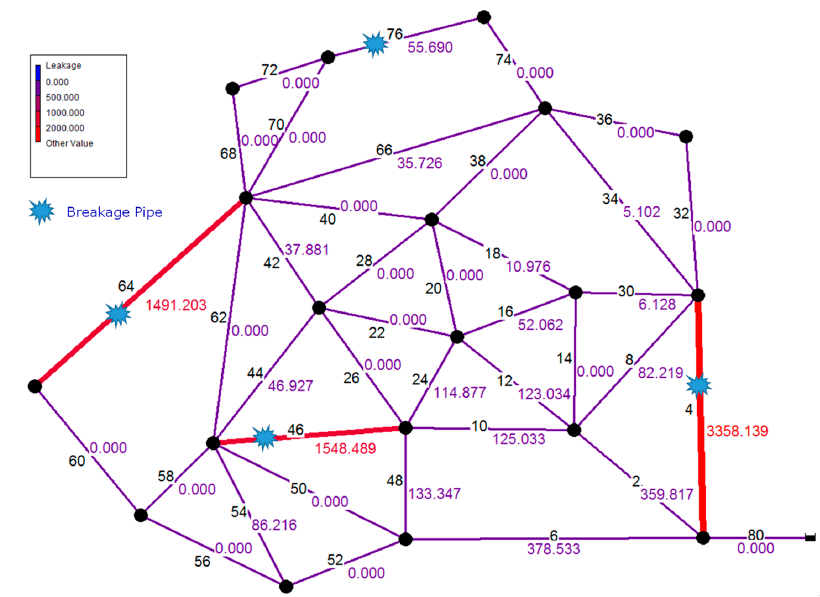
Figure 7. Results of estimation of lost flow rates (leakage, breakage) by pipe according to scenario S1.